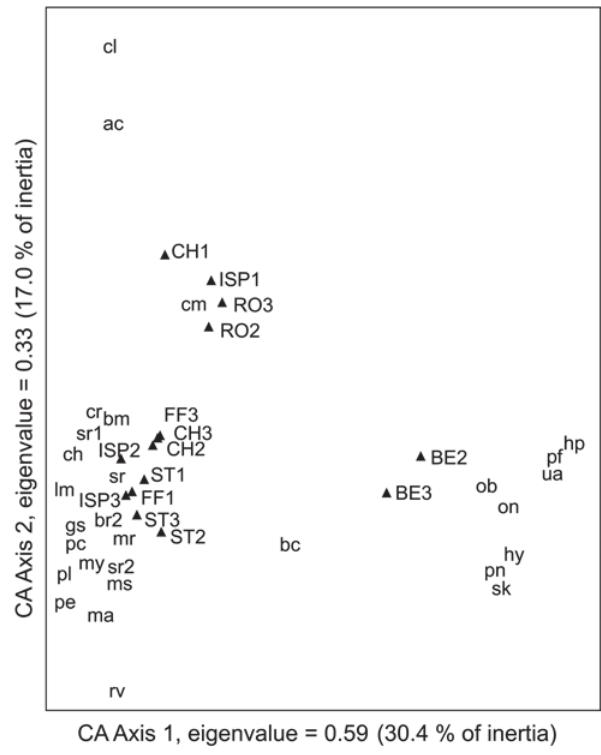
Fig. 3. CA ordination of six habitats across three seasons based on fish abundance of fishes collected with the large gill net only. Triangles represent habitats and crosses repre- sent species. Habitat names correspond to those in Table